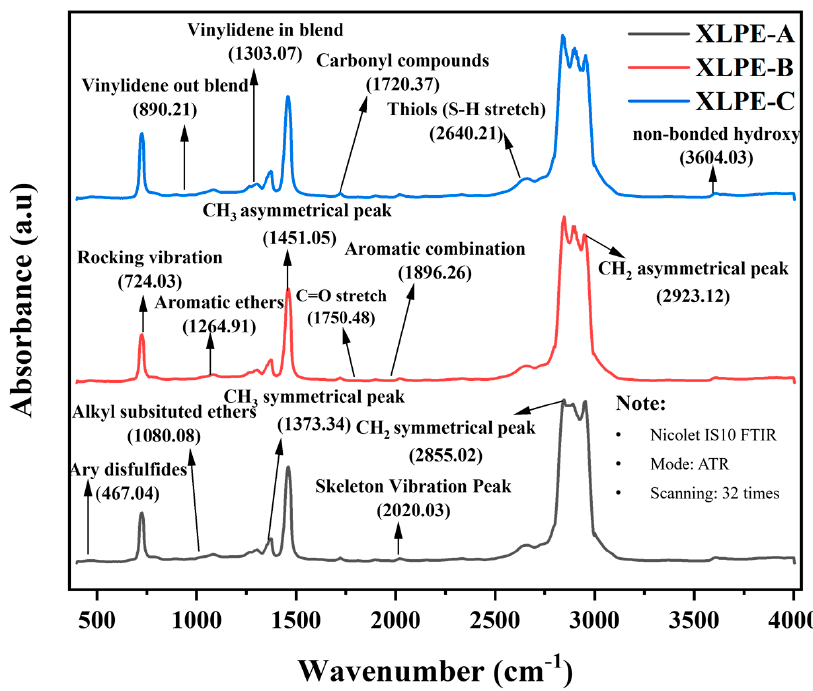
Figure 5. Identification of Functional groups/recognized peaks by Fourier transform infrared (FTIR) for XLPE prepared with DCP content of 1.4% (XLPE-A), 1.7% (XLPE-B) and 2% (XLPE-C). The peak mark at 467 cm − 1 specifies the presence of Aryl disulfides S-S stretch from the thilos and thio-substituted compounds. The peak mark at 2640 cm − 1 specifies the thiols compounds showing the S-H stretch. The presence of S-S and S-H stretch shows the occurrence of antioxidants in XLPE materials. It is stated that the addition of antioxidants in polymers improves the electrical and material characteristics [20]. The peak mark at 724 cm − 1 corresponds to the methylene CH 2 rocking vibration. The peaks at 1373 cm − 1 and 1451 cm − 1 specify the presence of CH 3 symmetrical and asymmetrical bending. The peak at 1720 cm − 1 shows the carboxylic acids/ketones indicating the carbonyl compounds in the material. The absorbance of important peaks is shown in Table 3. Table 3. Absorbance of identified peaks correspond to the wavenumber (cm − 1 ). Peaks Correspond to the Wavenumber (cm − 1